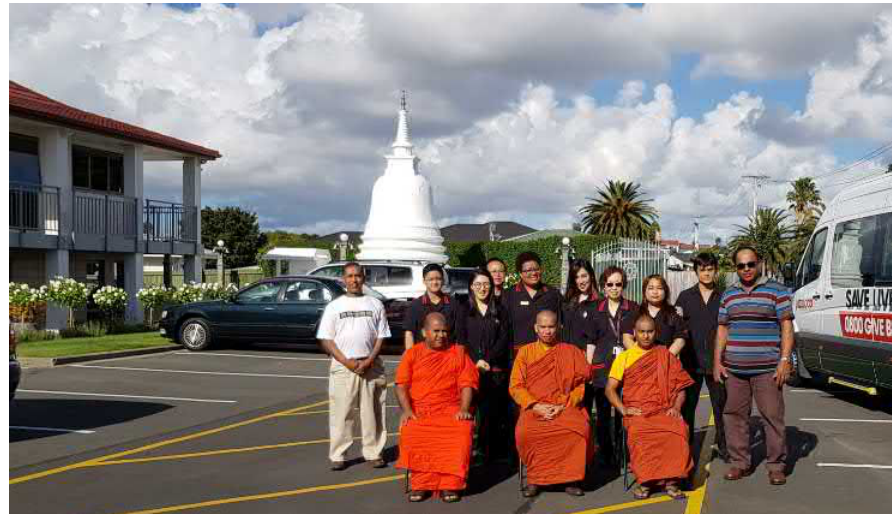
Figure 5: Srilankaramaya Buddhist temple, Ōtāhuhu, Auckland, after a blood donation drive in 2018. The temple holds such drives regularly. (Photo courtesy of Srilankaramaya Buddhist temple)